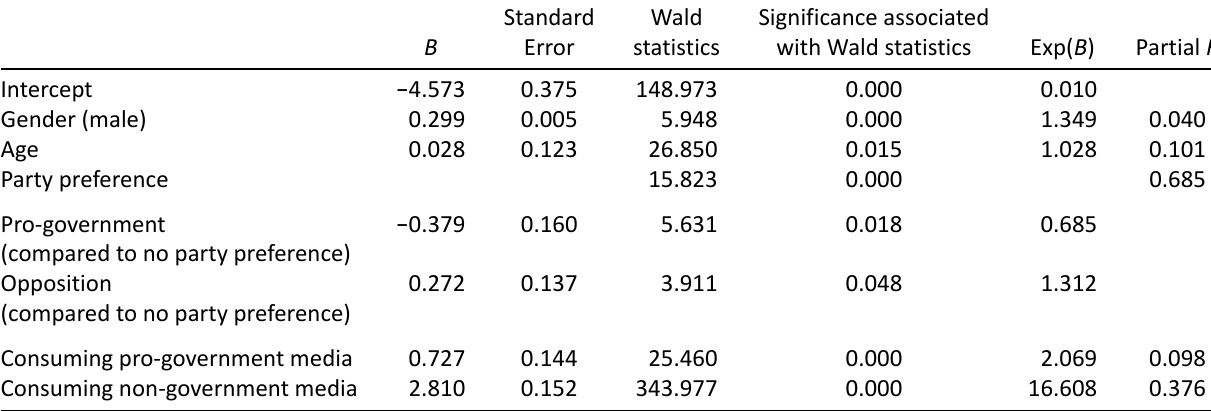
Table 2. Effect of the variables on the grey‐zone media consumption (only significant correlations